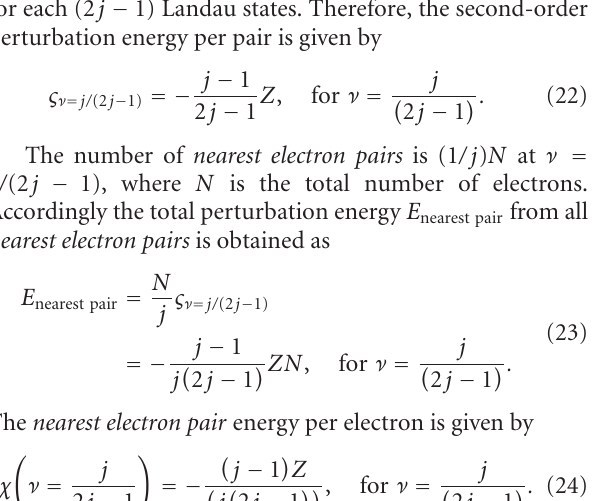
Figure 5: Connections between di ff erent